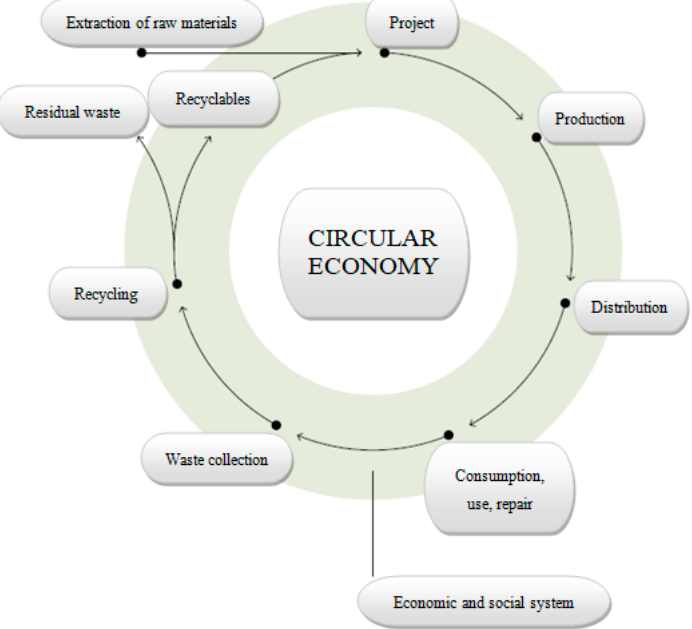
Figure 1. Diagram of circular economy, source: own study based on